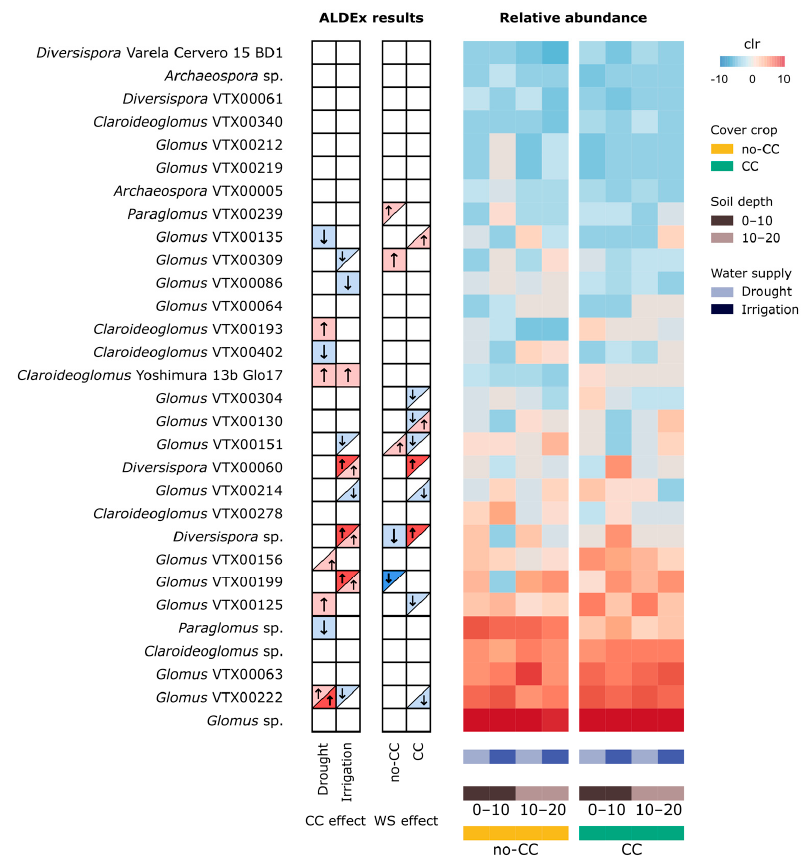
Figure 5. Changes in the relative abundance of soil of arbuscular mycorrhizal fungi (AMF) VTs in response to cover crop (CC) and water supply (WS) treatments at two different soil depths (0–10 and 10–20 cm). The table on the left summarizes the differential abundance testing results (ALDEx2) for CC and WS at each level of WS and CC, respectively. In the left side table, arrows and colors indicate an increase (red, ↑ ) or decrease (blue, ↓ ) in response to WS (i.e., irrigation) and CC. When effects were only observed at one soil depth, only half of the box is shaded (upper left: 0–10 cm; lower right: 10–20 cm). Taxa with |effect size| > 1 are shown in darker colors and thicker arrows on the table; the rest of the highlighted taxa have |effect size| > 0.5 but <1. In the heatmap, VT relative abundance is expressed as centered log ratio (clr).